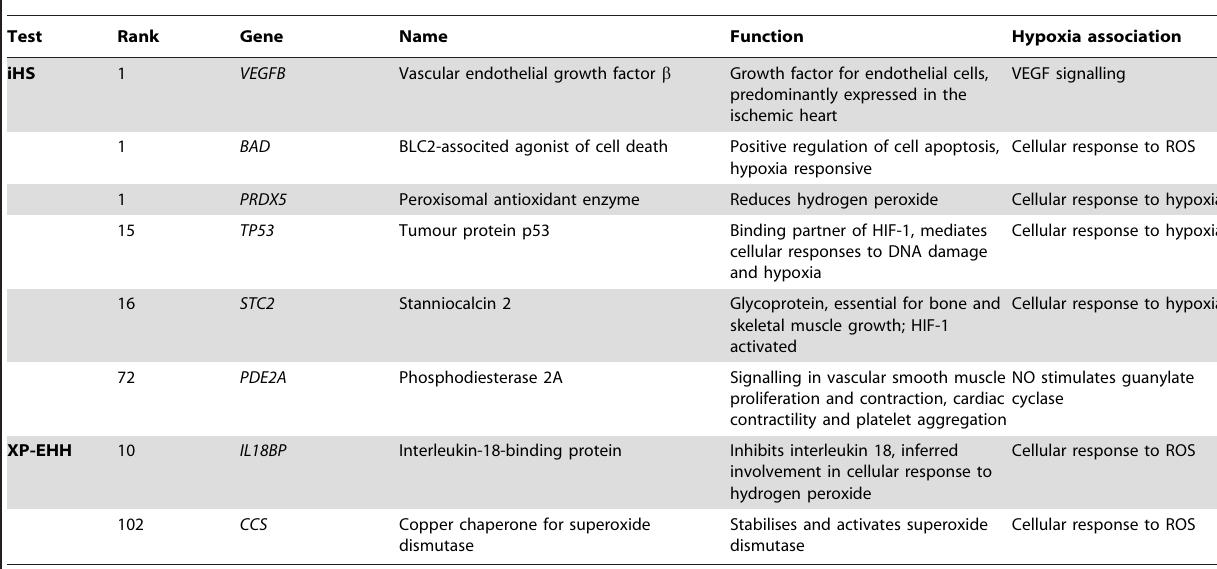
Table 4. Hypoxia candidate genes in the 1% of iHS and XP-EHH results in